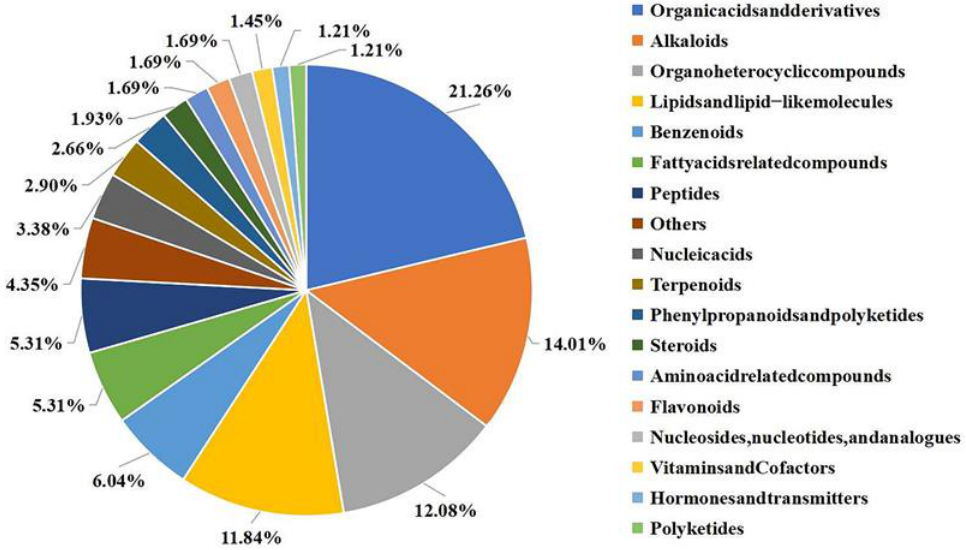
Figure 3. Relative proportions of different types of metabolites in J-15. Different colors represent different classifications of compounds and their proportions. All compounds with their affiliation to the particular group can be found in Table S5. Table 1. Alkaloids in